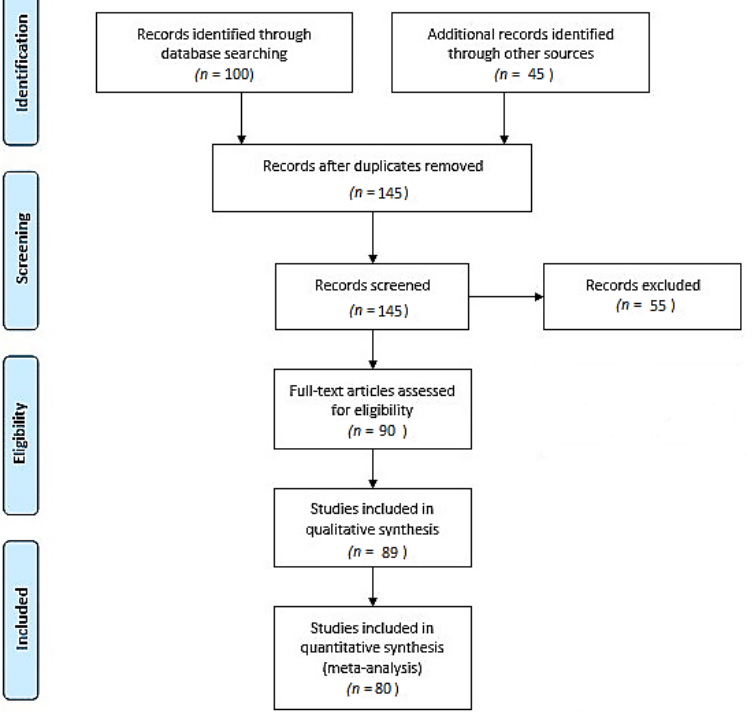
Figure 1. The flow diagram of the review process according to PRISMA guidelines [32,33].